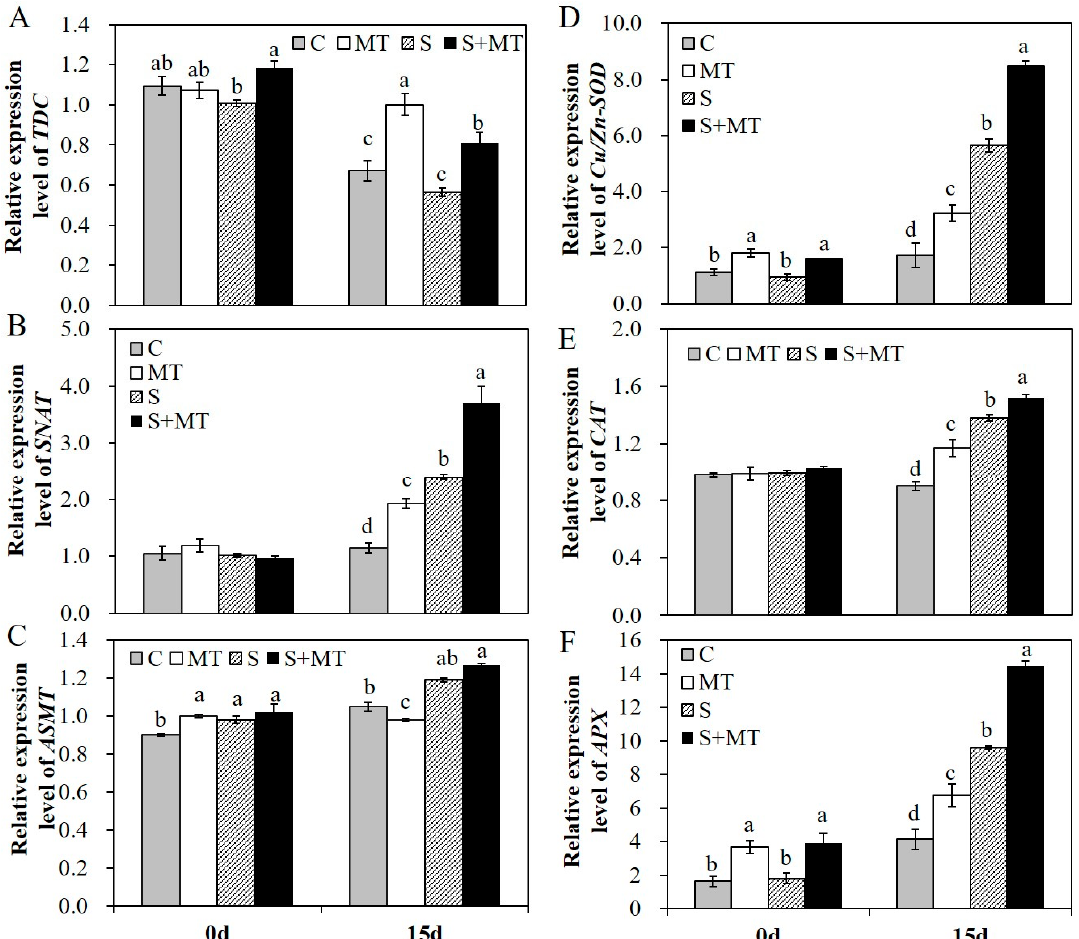
Figure 6. Relative expression level of several selected genes in the melatonin biosynthesis pathway and genes encoding antioxidative enzymes involved in reactive oxygen species (ROS) metabolism A–C, relative expression level of tryptophan decarboxylase ( TDC ) ( A ), serotonin N-acetyltransferase ( SNAT ) ( B ), and N-acetylserotonin methyltransferase ( ASMT ) ( C ) in the melatonin biosynthesis pathway in different treated plants before and after 200 mM NaCl treatment for 15 days; D–F, relative expression level of Cu/Zn-SOD ( D ), CAT ( E ), and ascorbate peroxidase ( APX ) ( F ) in leaves of alfalfa plants before and after 200 mM NaCl treatment for 15 days. Data are represented as means ± SE ( n = 3), and bars with different letters indicate the differences between these four different groups according to ANOVA analysis ( p < 0.05).